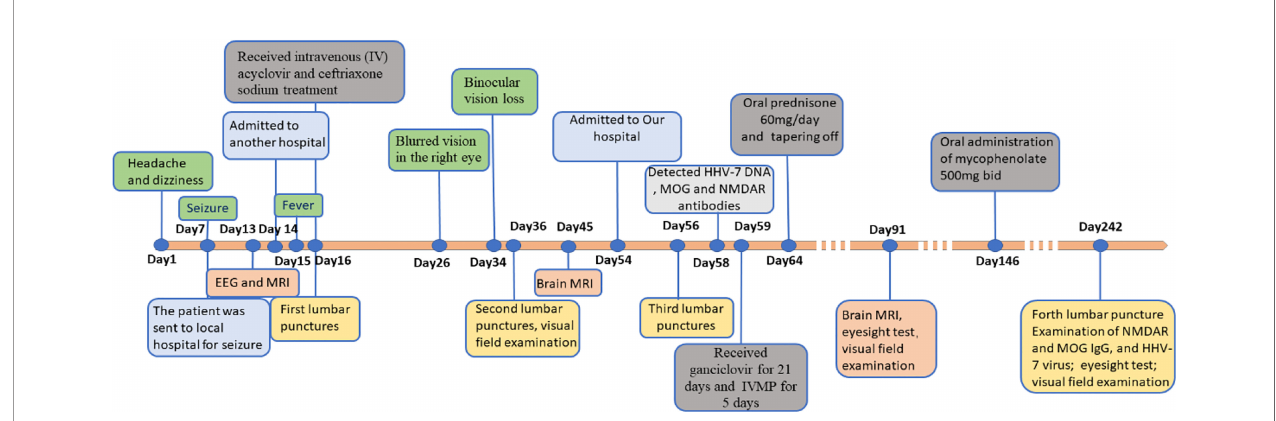
FIGURE 3 | Timeline with clinical manifestation, treatment progression and diagnosis time. EEG, Electroencephalograph; MRI, Magnetic Resonance Imaging; IVMP, Intravenous methylprednisolone; HHV-7, Human Herpesviruses-7; NMDAR, Anti-N-methyl-D-aspartate receptor; MOG, Myelin oligodendrocyte